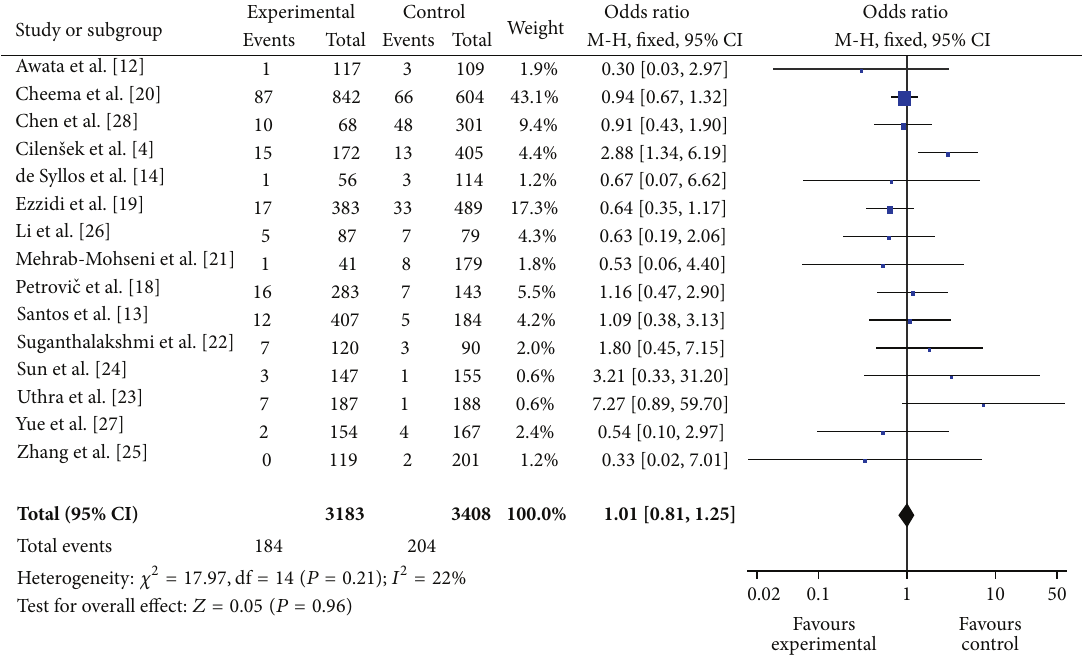
Figure 5: The forest plot of aa versus bb + ab of eNOS polymorphism and overall DR